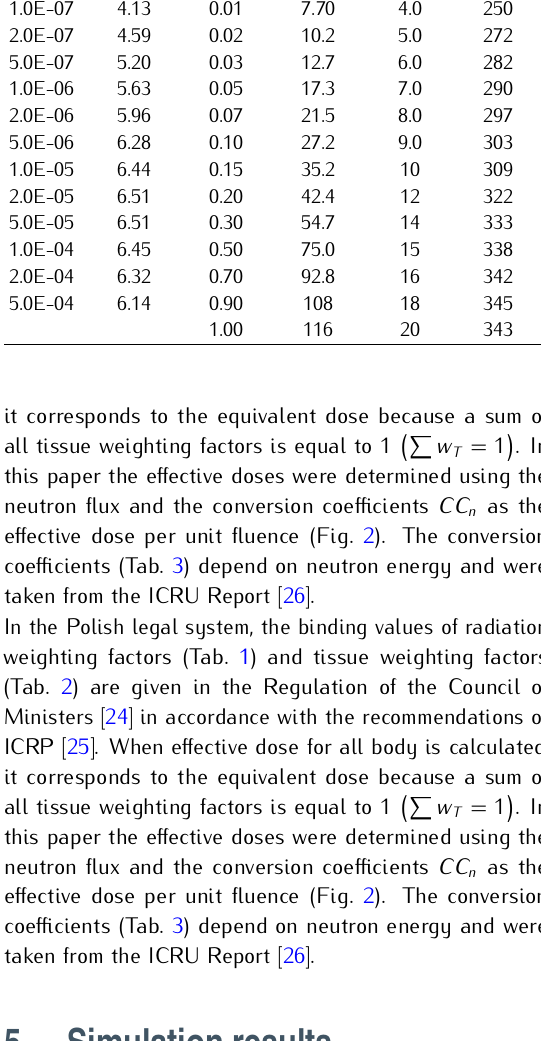
Table 3. The conversion coefficients CC unit fluence. Energy CC n